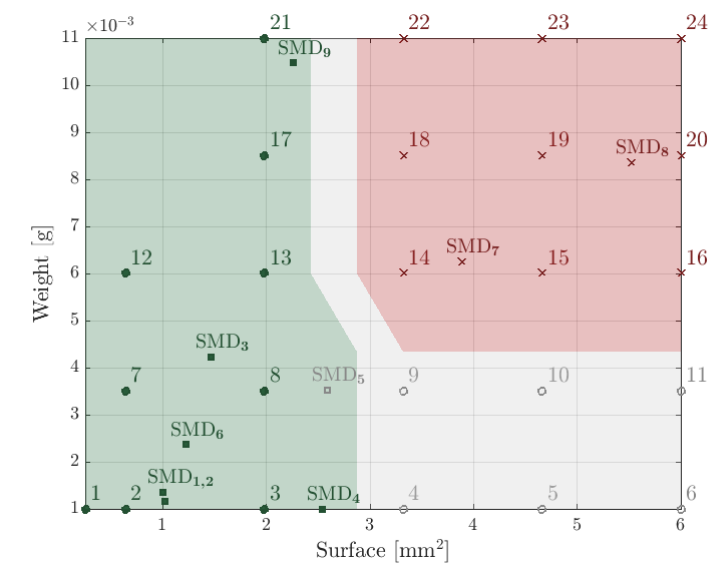
Figure 6. Results of the picking tests. Fused silica components (numbered from 1 to 24) and surface- mounted devices (numbered from SMD 1 to SMD 9 ) of varying surfaces and weights were tested. The green area represents a successful picking and self-alignment. In the gray area, the picking occurred but the self-alignment did not. The red area codes for the failure of both the self-alignment and the